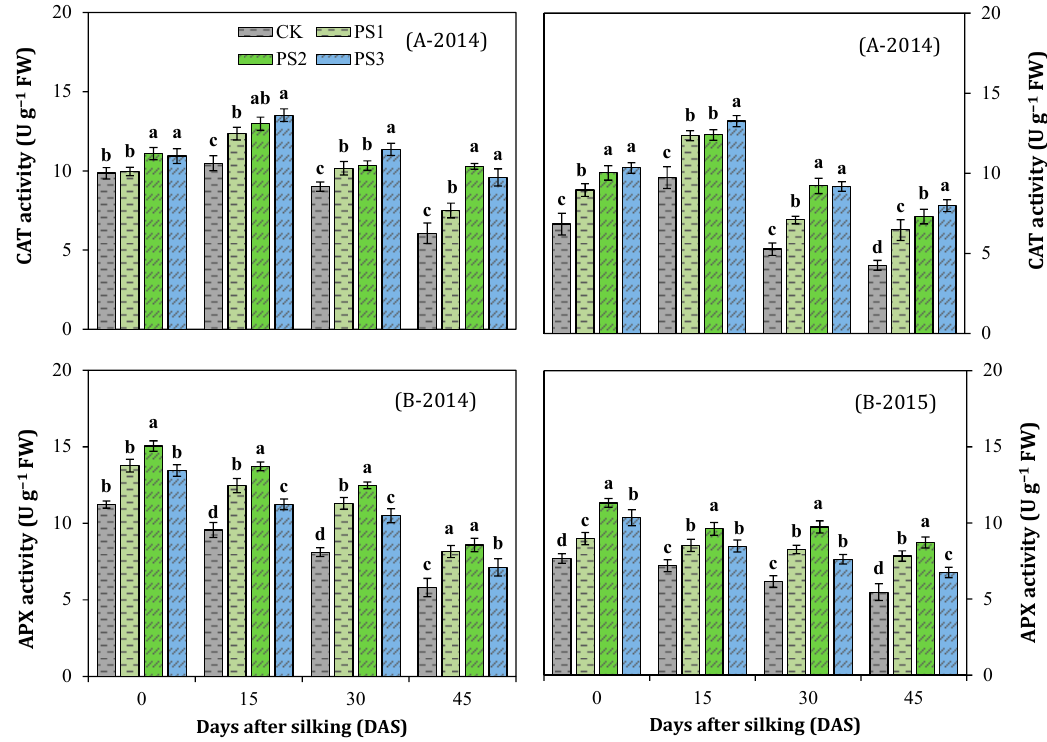
Figure 7. Effects of paclobutrazol treatments on ( A ) catalase, CAT, and ( B ) ascorbate peroxidase, APX, activity in maize leaves during 2014 and 2015. Data are presented as mean ± SD of three measurements. Different small letters on the bars indicate significant differences at P < 0.05 (LSD test). The abbreviations of treatment names are the same as those described in Figure 2.